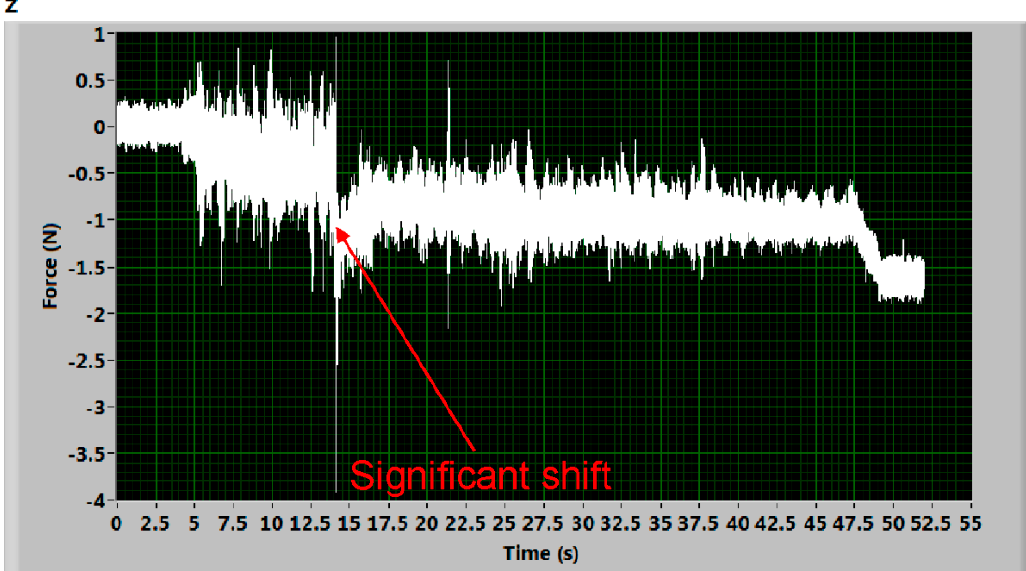
Figure 6. Deformation force signal with a significant shift during the beginning part of cutting (sample Hardox 500 plate, traverse speed 50 mm/min).